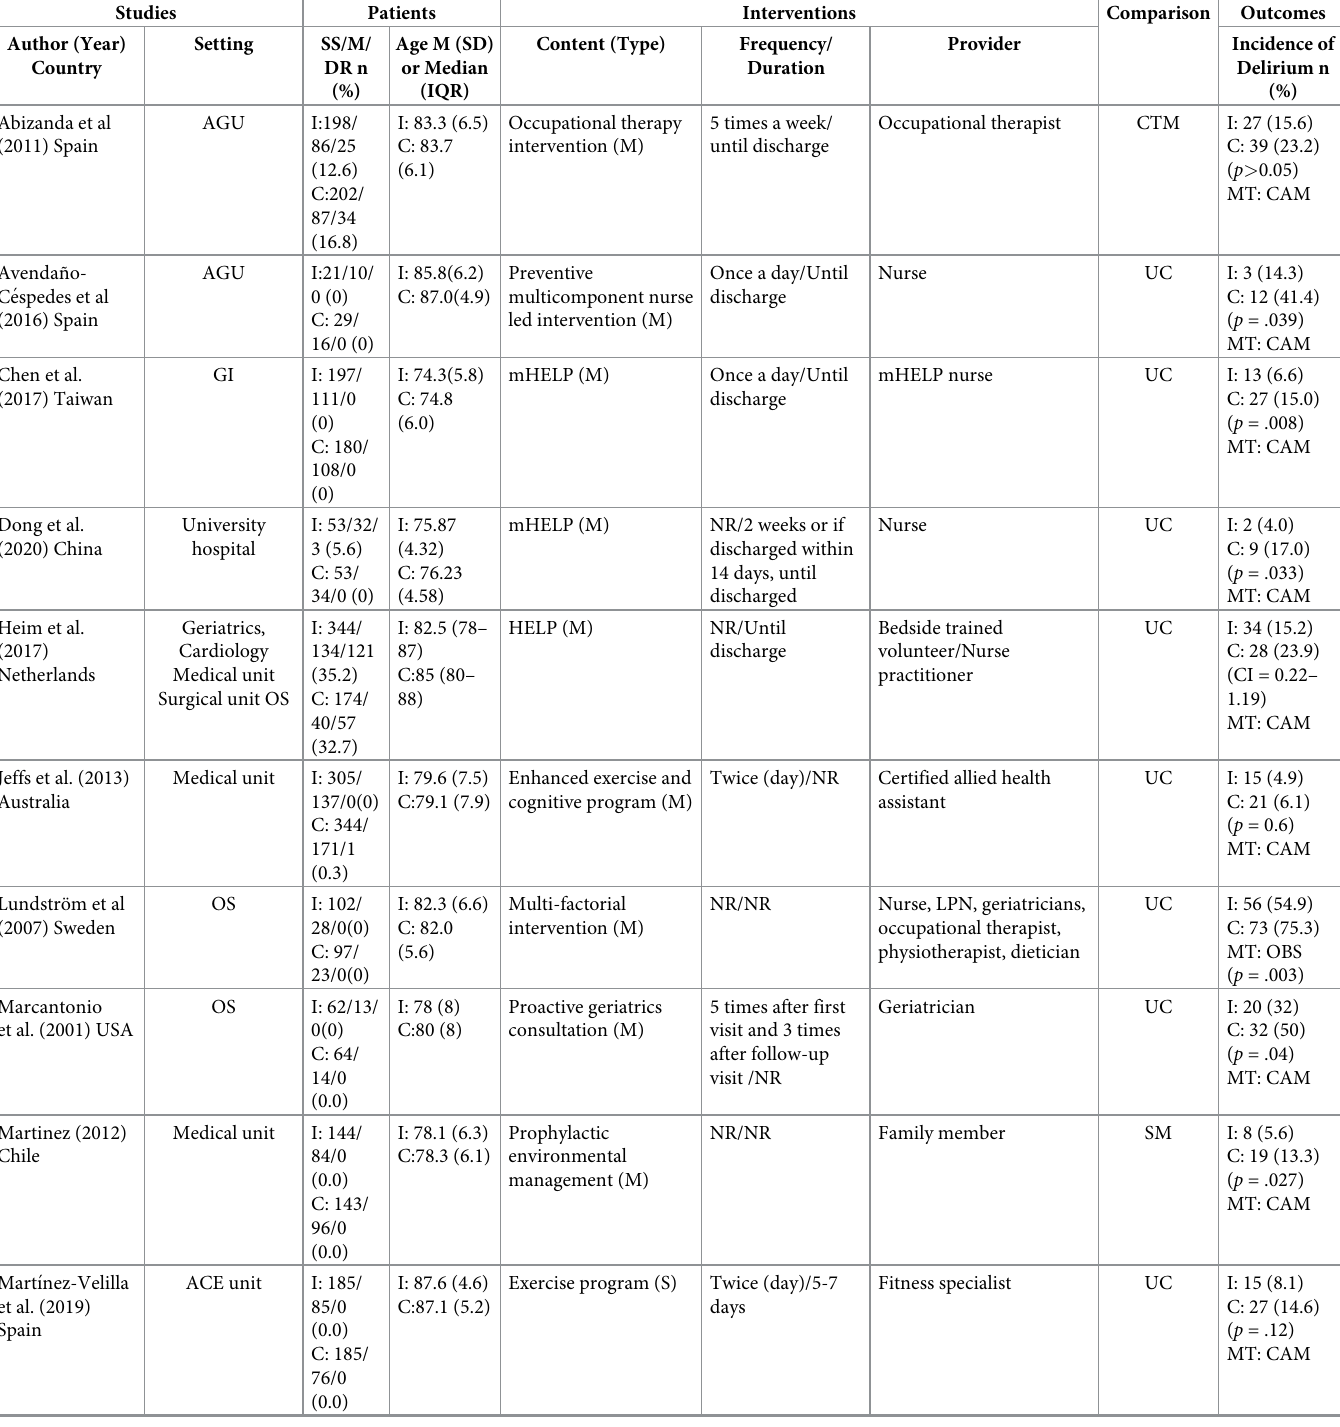
Table 1. Descriptive summary of included studies (N =